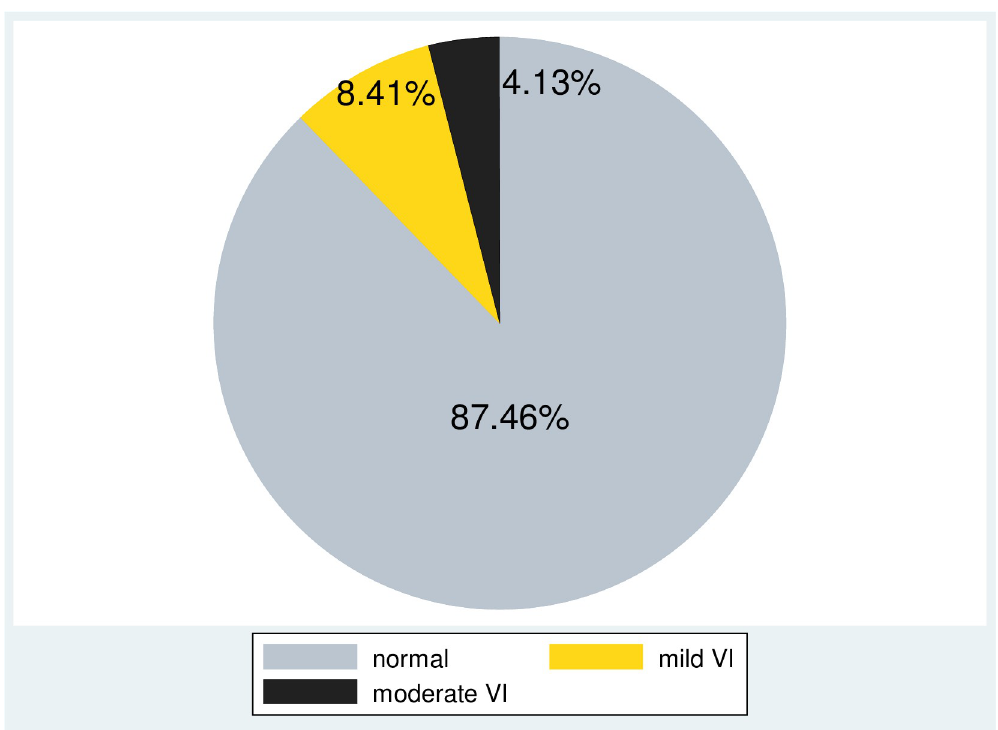
Fig 2. Distribution visual impairment among medical and health science, University of Gondar, Northwest Ethiopia, 2020.